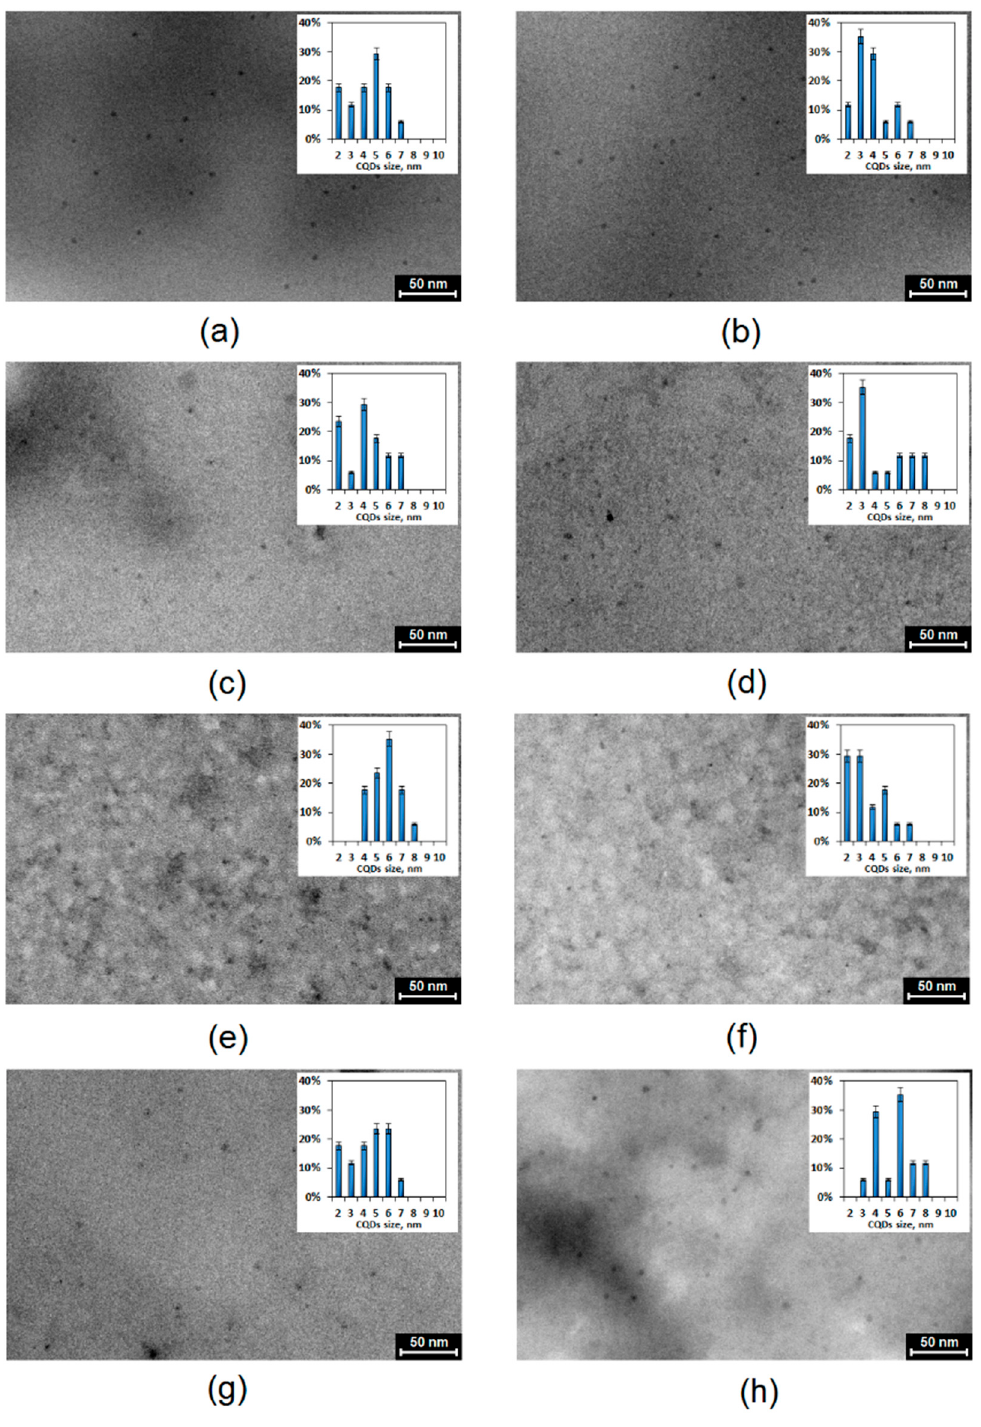
Figure 4. TEM images of the prepared samples ( a )—CQDs-1; ( b )—CQDs-2; ( c )—CQDs-3; ( d )—CQDs-4; ( e )—CQDs-5; ( f )—CQDs-6; ( g )—CQDs-7 and ( h )—CQDs-8.